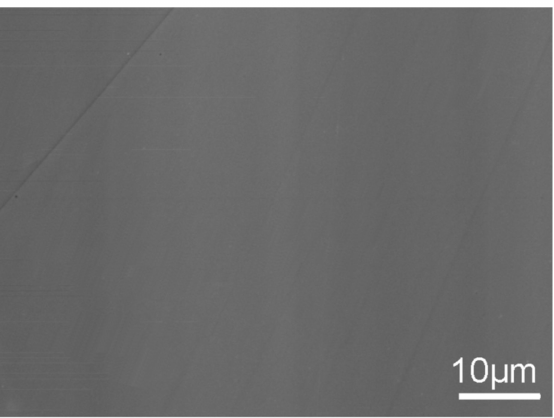
Figure 3. SEM image of a homogeneous glass surface with no apparent impurities